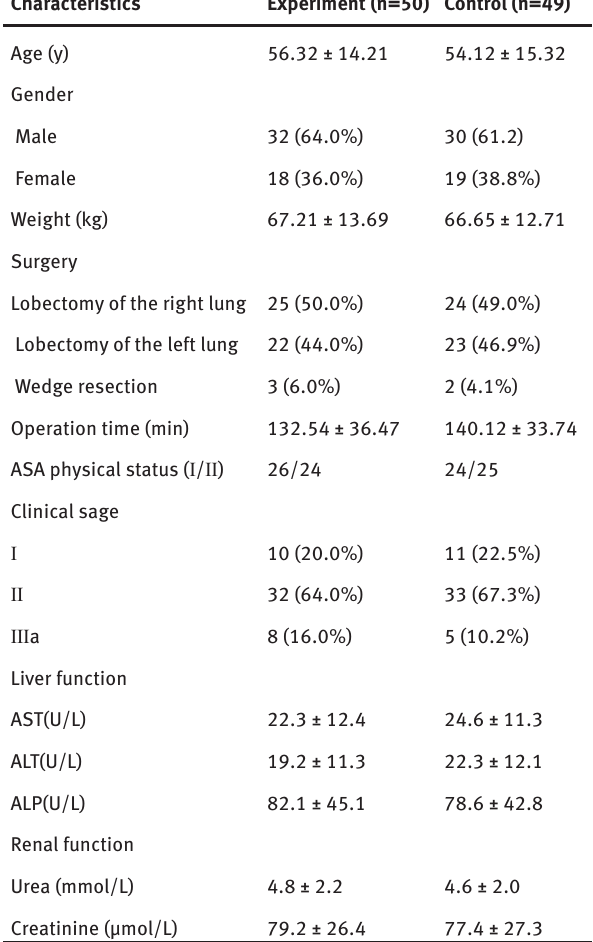
Table 1: The main features of the two groups.